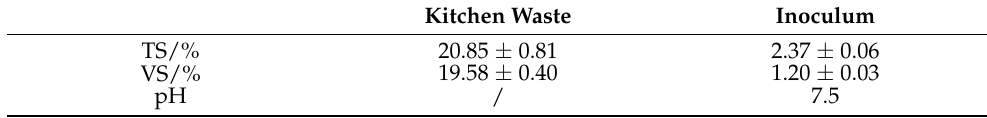
Table 1. Physicochemical properties of substrate and